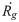
(a) F-actin distribution along the force direction (Z-axis) of the most representative trajectory before the 4th pulling at t = 600 s (blue), after the 4th pulling at t = 601 s (orange), and after the long-timescale chemical evolution at t = 750 s (yellow). (b-d) Corresponding simulation snapshots before pulling, after pulling, and after chemical evolution, respectively. (e) Standard deviations (σ) of the F-actin distribution along the force direction before pulling (blue), after pulling (orange), and after 150 s of chemical evolution (yellow) at the third, fourth, and fifth pulling events. σ are averaged over 10 duplicated trajectories, and error bars represent the standard errors. (f) The radius of gyration, Rg and (g) the rate of Rg change, Rg˙, of actin networks in Case i with 500 nm pulling (red) and in Case iv without pulling (green). Shaded colors and error bars are the standard deviations of 10 duplicated trajectories for Case i and 5 duplicated trajectories for Case iv.